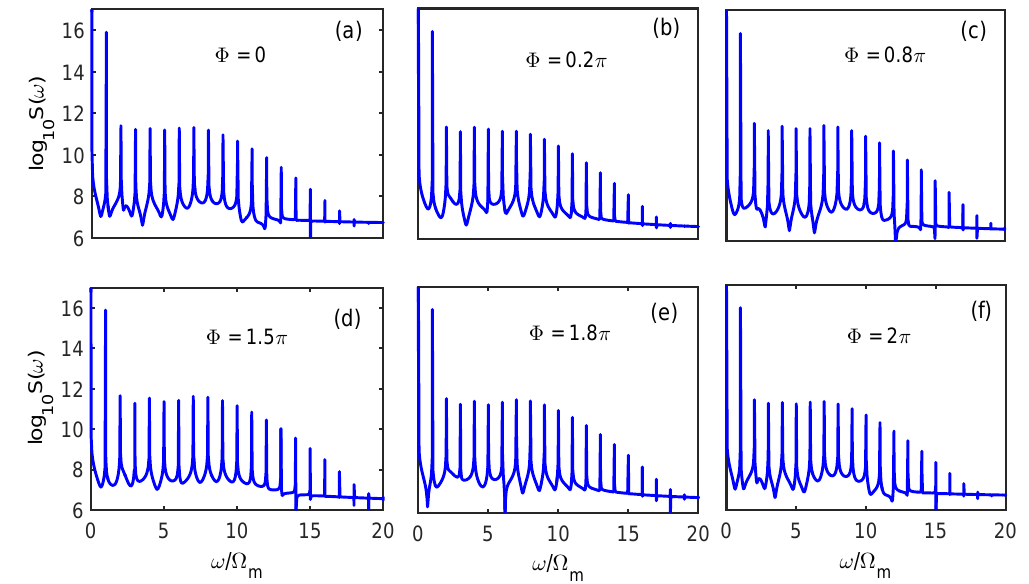
Figure 7. The high-order sideband spectra output from the hybrid atom–cavity optomechanical system with electric interaction (the charge number n = 5) are shown with different phase: ( a ) Φ = 0 π ; ( b ) Φ = 0.2 π ; ( c ) Φ = 0.8 π ; ( d ) Φ = 1.5 π ; ( e ) Φ = 1.8 π ; ( f ) Φ = 2 π . The other parameters are the same as those in Figure